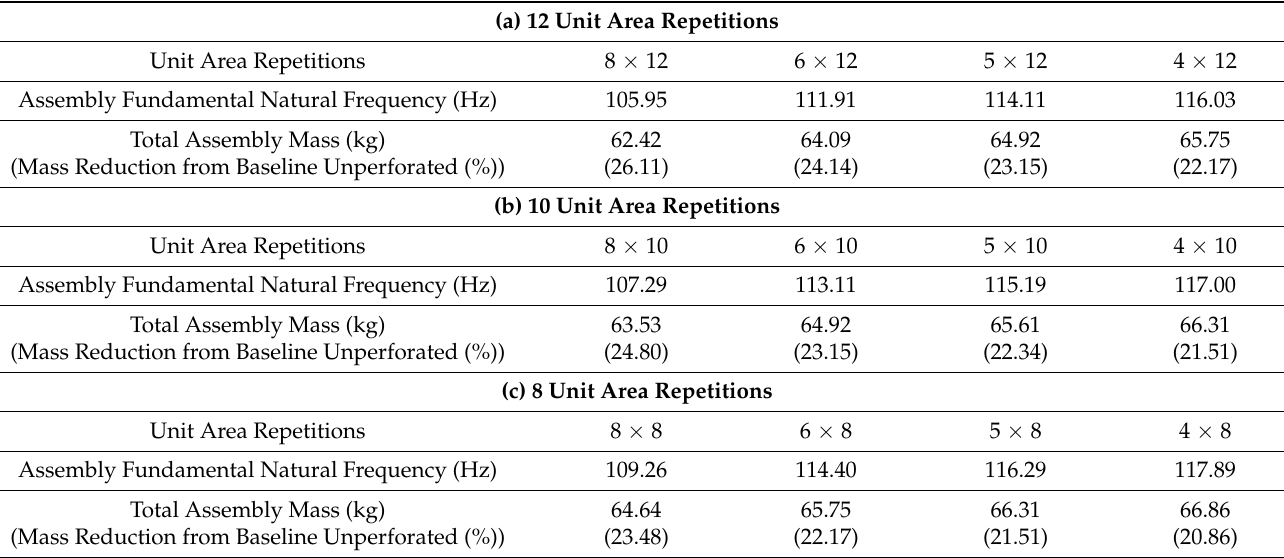
Table 6. Fundamental natural frequency and total mass for the unit area repetition cases.